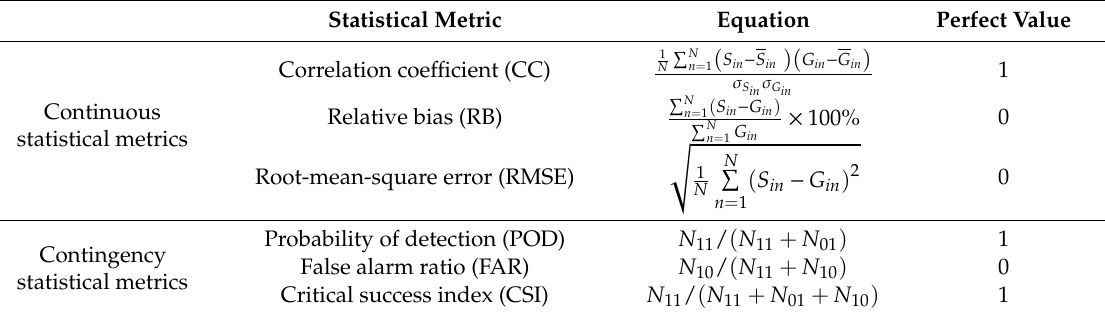
Table 1. List of continuous and contingency statistical